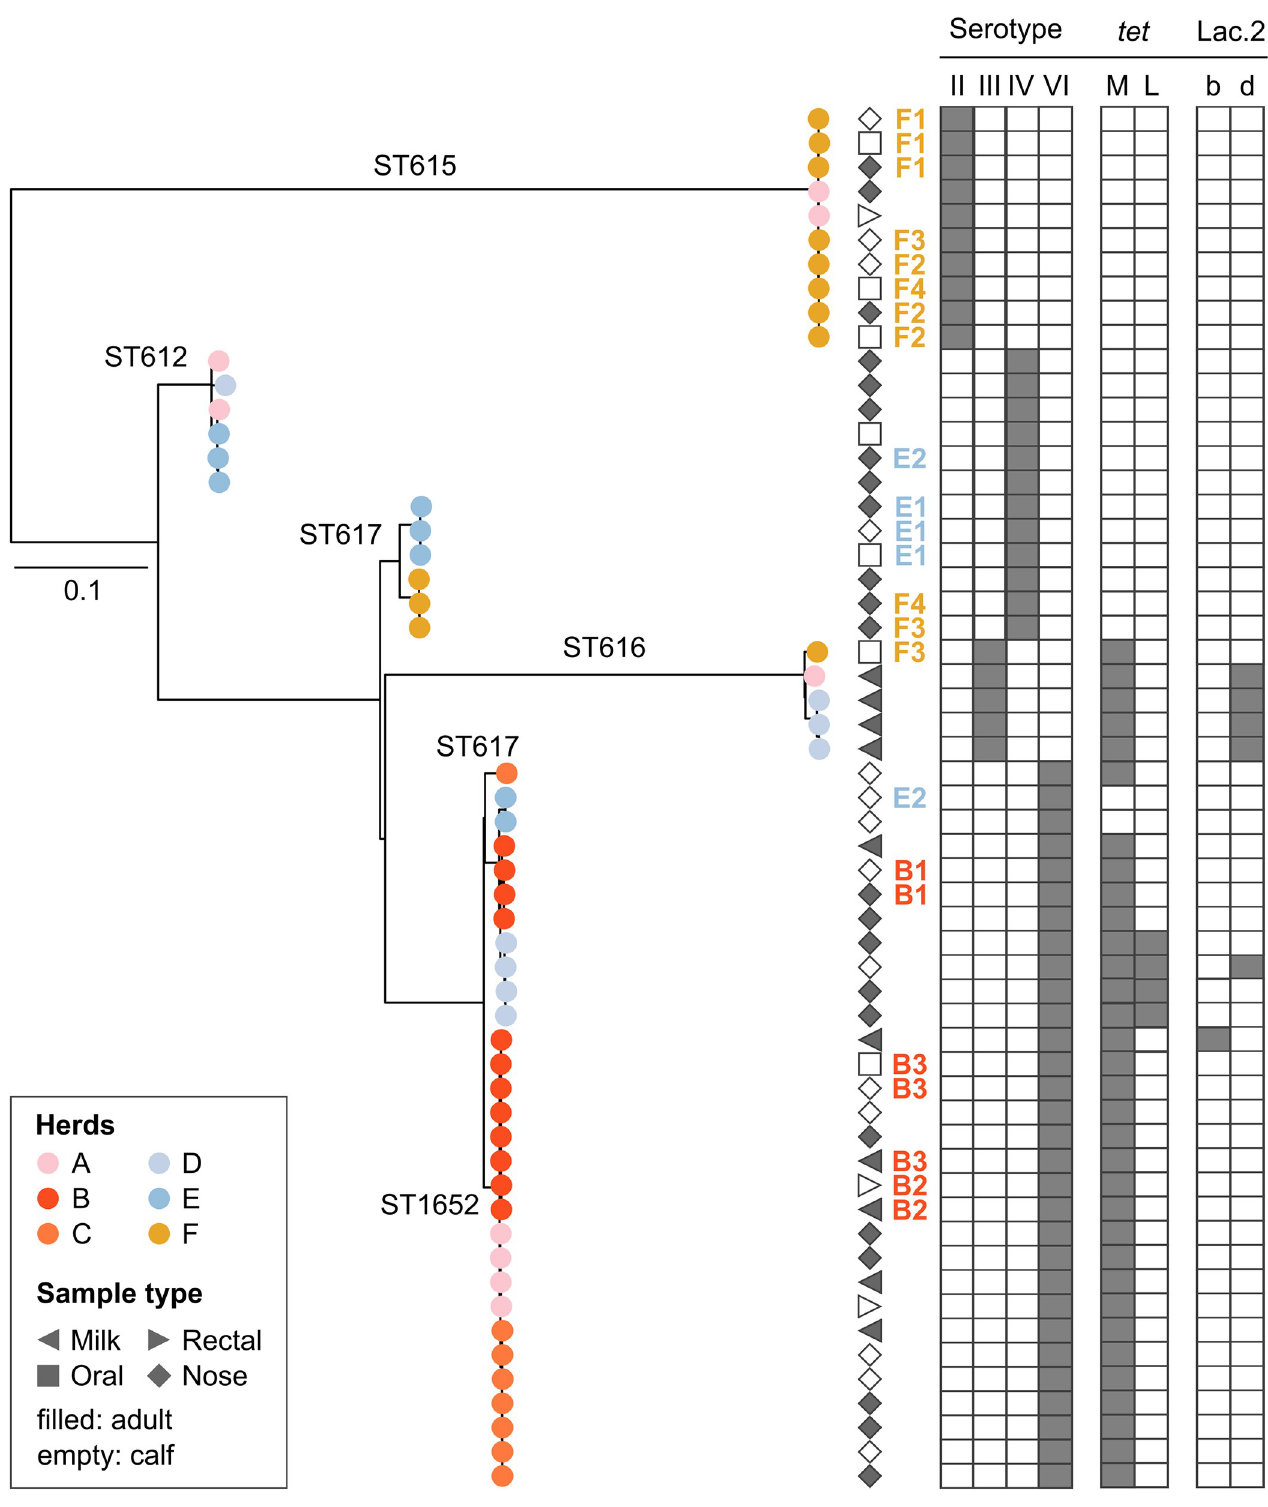
Fig 3. Maximum likelihood phylogenetic tree based on a core genome alignment for 57 group B Streptococcus isolates from milk and nasal, rectal and oral mucosa of dromedary camels in Kenya. Leaf colours indicate herd of origin with sequence types (STs) indicated on the branches. Geometric shapes correspond to sample source, while age category (adult or calf) is indicated by shading. Combinations of letters and numbers show adult-calf pairs within herds (B1, B2, B3, E1, E2, F1, F2, F3, F4) with colour corresponding to herd of origin. Grey blocks mark capsular serotype, tetracycline resistance genes, and the presence of a lactose operon in the genome (variants Lac.2b and Lac.2d). Tree was rooted at midpoint.